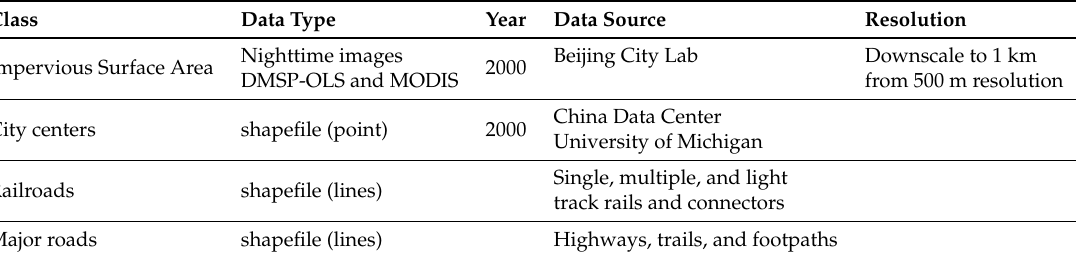
Table 1. Data content and